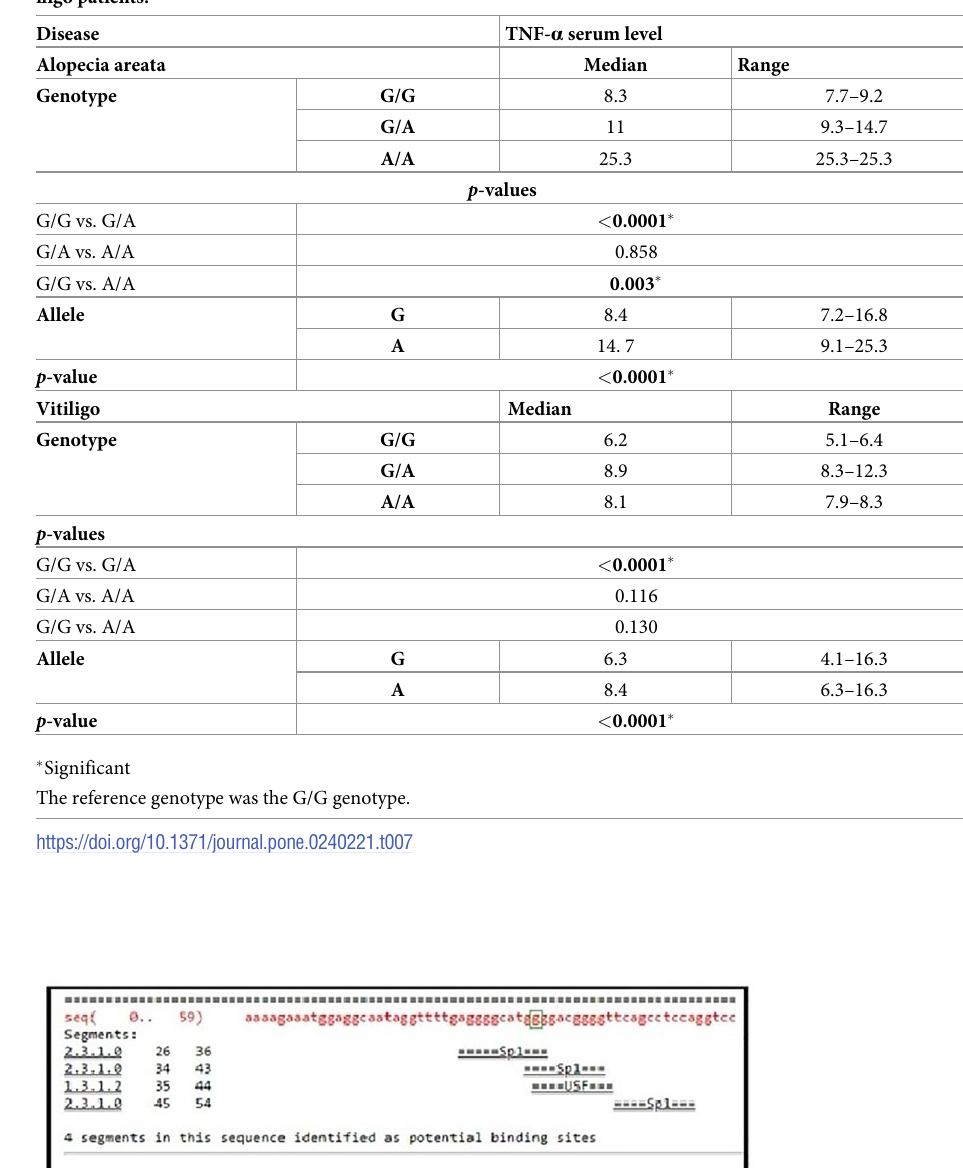
Table 7. Differences in TNF- α serum level according to the difference in genotypes among alopecia areata and vit- iligo patients.